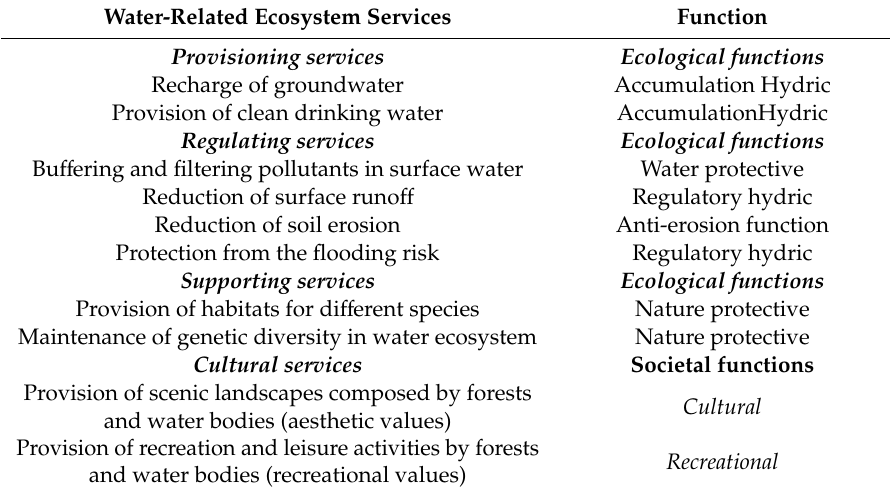
Table 1. The list of water-related ecosystem services provided by